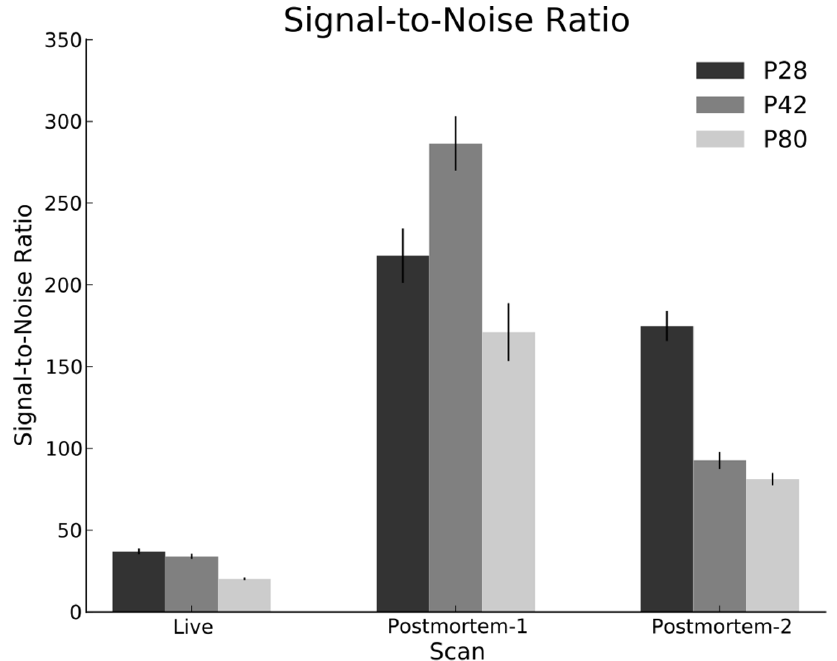
Figure 7. Signal-to-noise ratio.